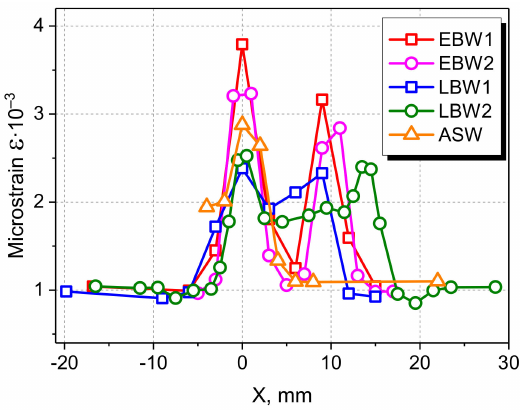
Figure 8. Lattice microstrain distributions vs. scan coordinate X for all investigated Charpy specimens.